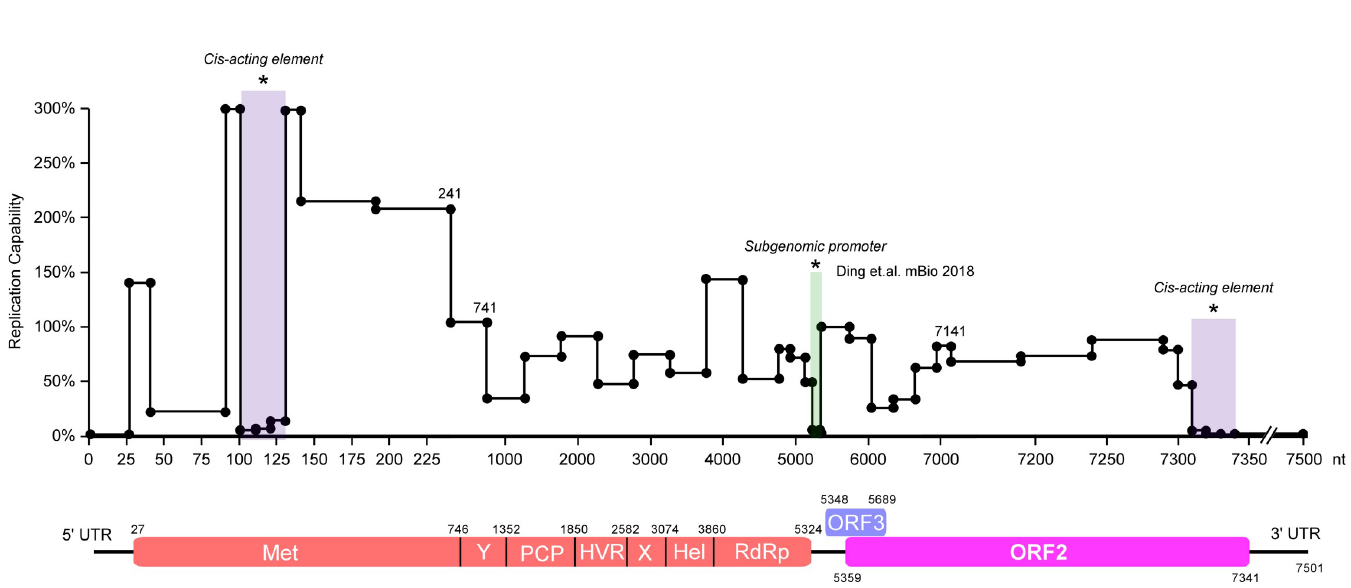
Fig 3. Localization of functional cis -acting elements in the HEV genome. The effect of sequences in the HEV genome on HEV replication capability is summarized based on the data in Figs 1 and 2, S1 and S2 Figs in this study (highlighted as purple) and published results (green) [35]. The Y axis shows the relative level of viral replication as determined in the viral replicon system when the corresponding region (shown on the X axis) in the HEV genome was deleted.